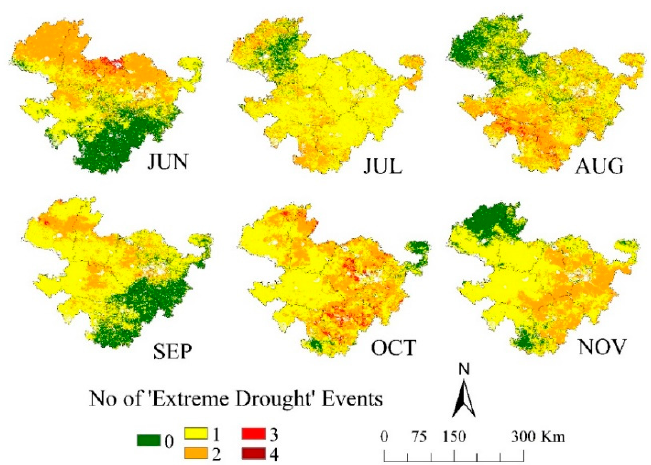
Figure 5. Spatio-temporal representation of method II-based number of extreme drought events (months of the highest number of drought frequencies) that occurred between 2001 to 2018. Figure 6 represents the spatial association between the CDI_M results from both methods.